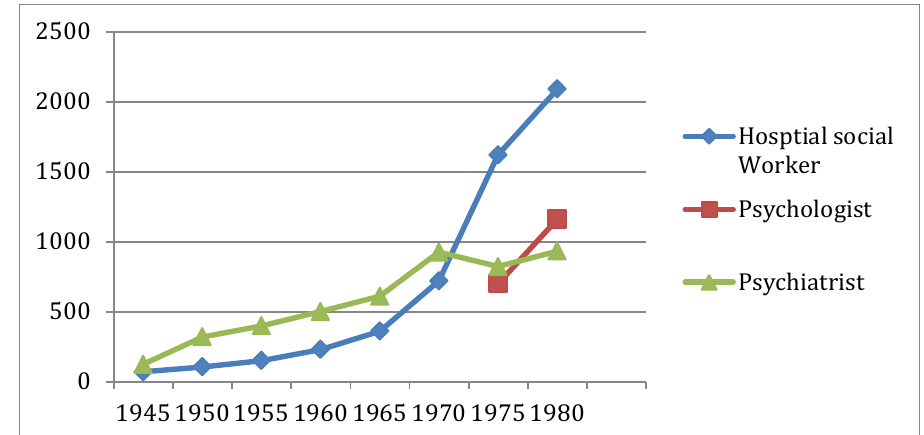
Figure 1 . The emergence of the professions in the field of social integration. Note: The figures include only social workers and psychologists employed in healthcare and emanate from official statistics; Statistics Sweden (SCB), historical database and from Annual Statistics in Swedish